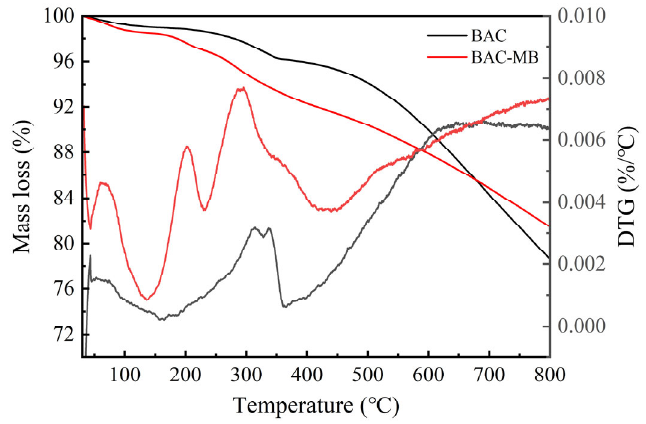
Figure 6. Thermal stability of the BAC.